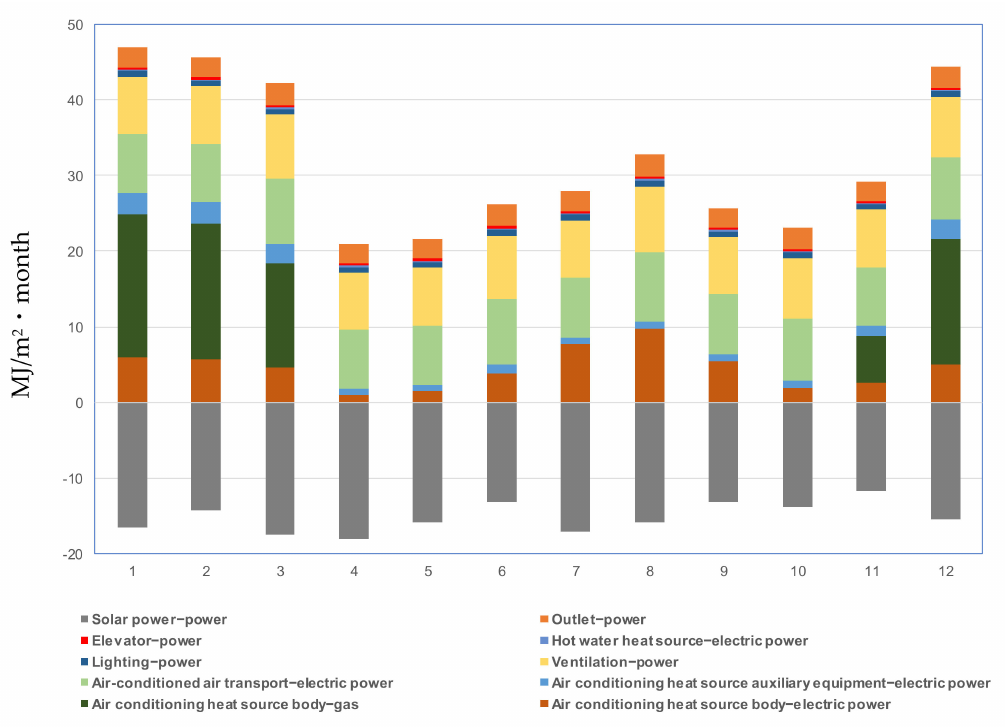
Figure 5. Breakdown of energy consumption of the building in each month.